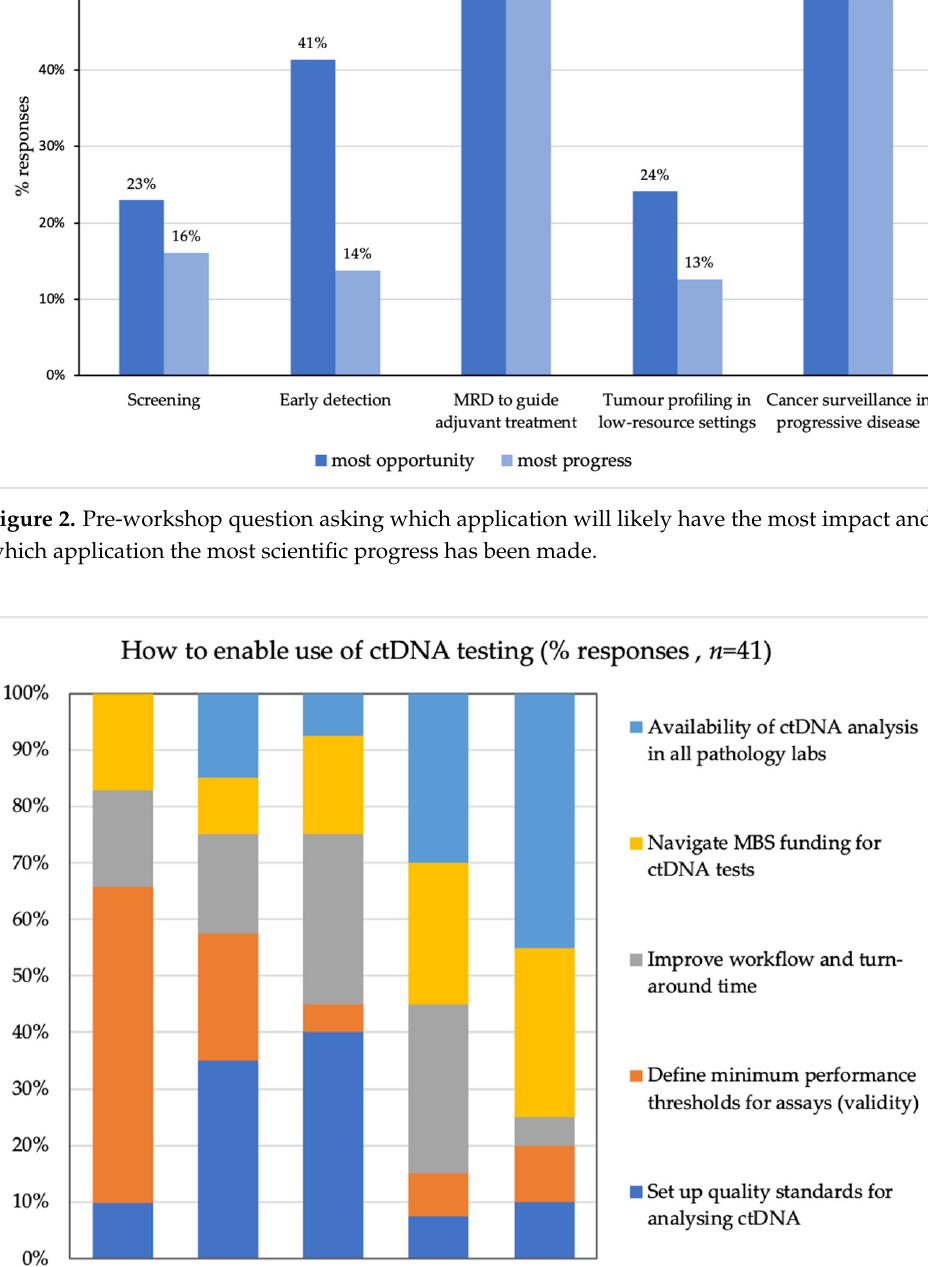
Figure 3. Results of ranking 5 statements related to clinical use of ctDNA.